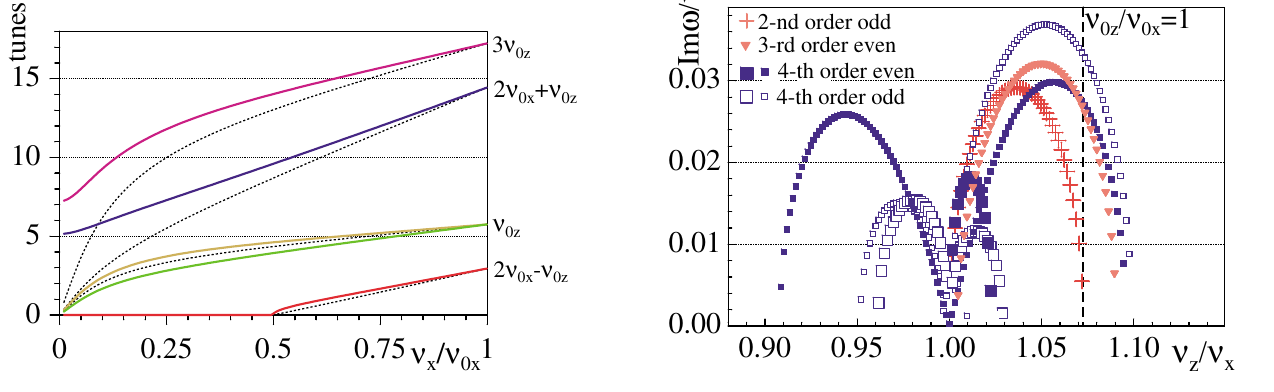
FIG. 3. (Color) Analytic results for third order even mode (cid:3) 2 and machine tunes (cid:10) =(cid:19) frequencies with (cid:19) z x (cid:3) 4 : 35 . 5 : 75 ; (cid:10) 0 x